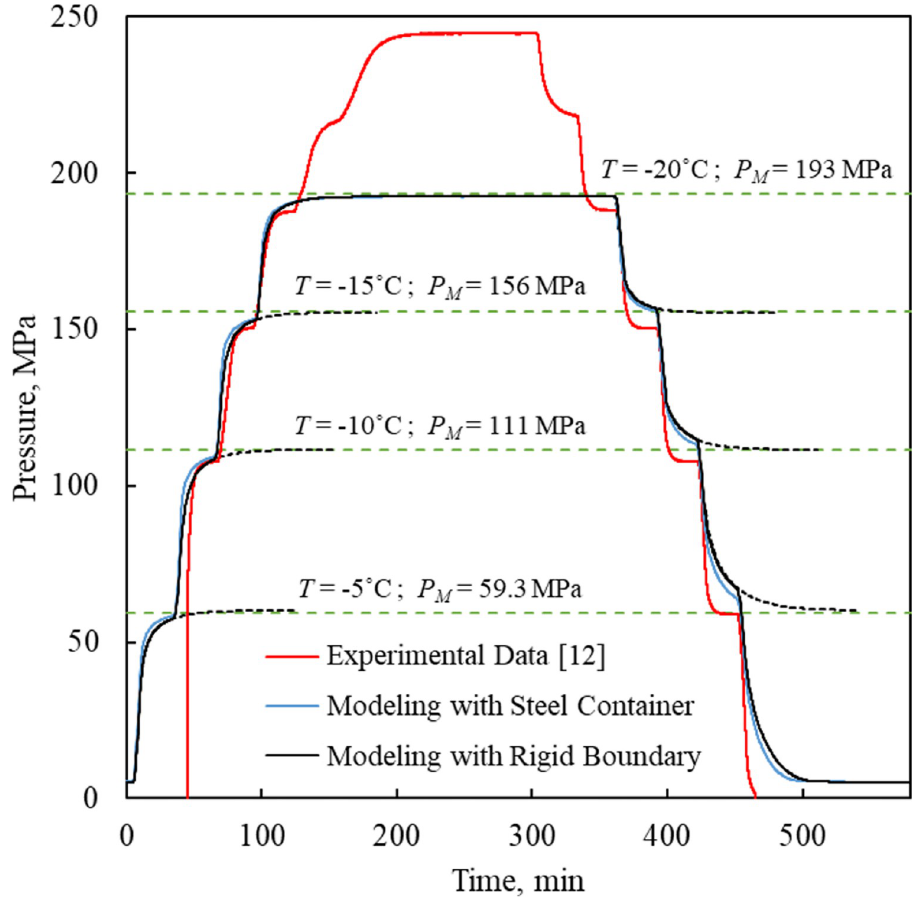
Fig 5. Comparison of experimental data [12] and 1D modeling results. Comparison of experimental data [12] and 1D modeling results for pressure history during the cooling and rewarming of the isochoric chamber illustrated in Fig 2A. Also overlaid are the equilibrium pressure values according to the phase